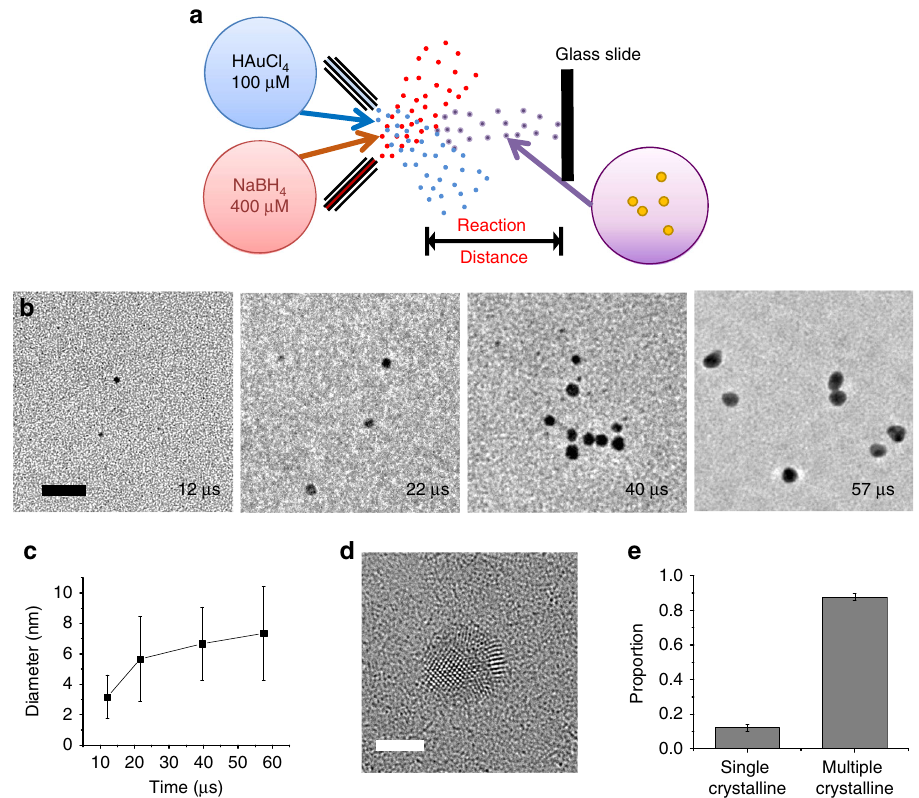
Fig. 1 Kinetically controlled AuNP growth using fused microdroplets. a Schematic of the experiment setup. Microdroplets containing 100 µ M HAuCl 4 solution were fused with the ones containing 400 µ M NaBH 4 solution. The crystallization process was kinetically controlled on the microsecond timescale by adjusting the traveling distance of the fused microdroplets. b TEM images of gold nanoparticles at different time points. Scale bar is 20 nm. c Time- course change in the diameter of the gold nanoparticles. d TEM image of a nanoparticle showing multiple crystalline structures. e Portion of nanoparticles with single or multiple crystalline structures synthesized in microdroplets. Error bars represent one standard deviation of three